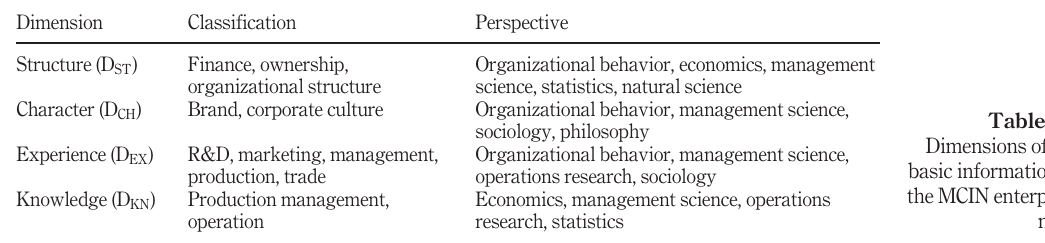
Table III. Dimensions of